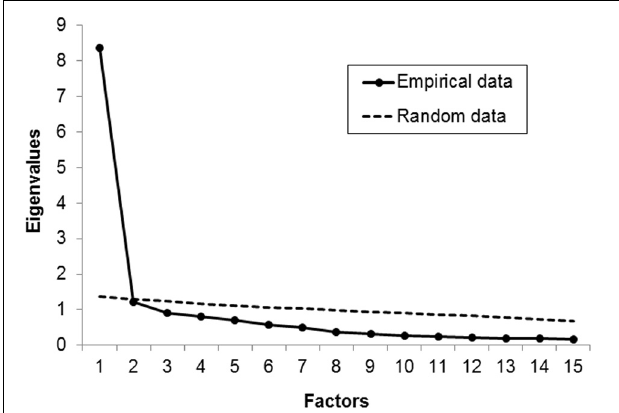
FIGURE 1 | Scree plot and parallel analysis of eigenvalues in study 1.